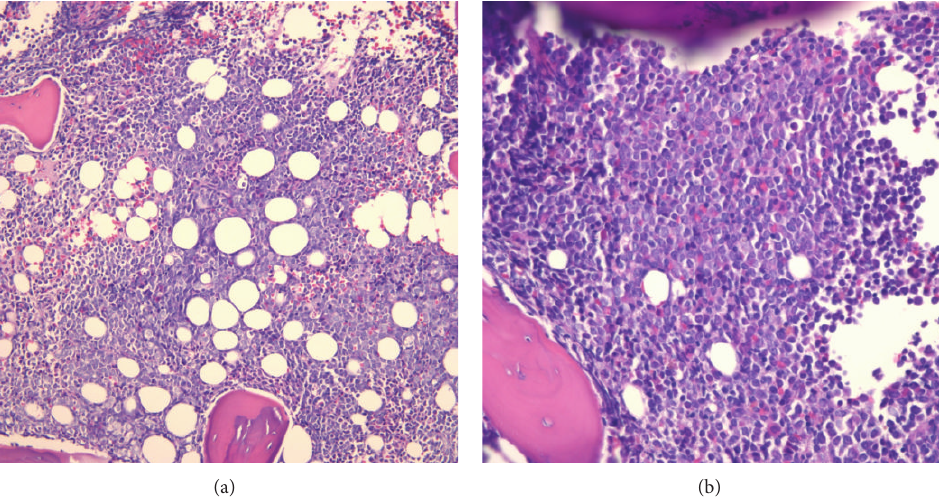
Figure 4: 100x (a) and 200x (b) powered core bone marrow biopsy demonstrating hypercellular marrow (approximately 40–80% cellularity) with interstitial blast infiltrate (80–90% of cellularity by